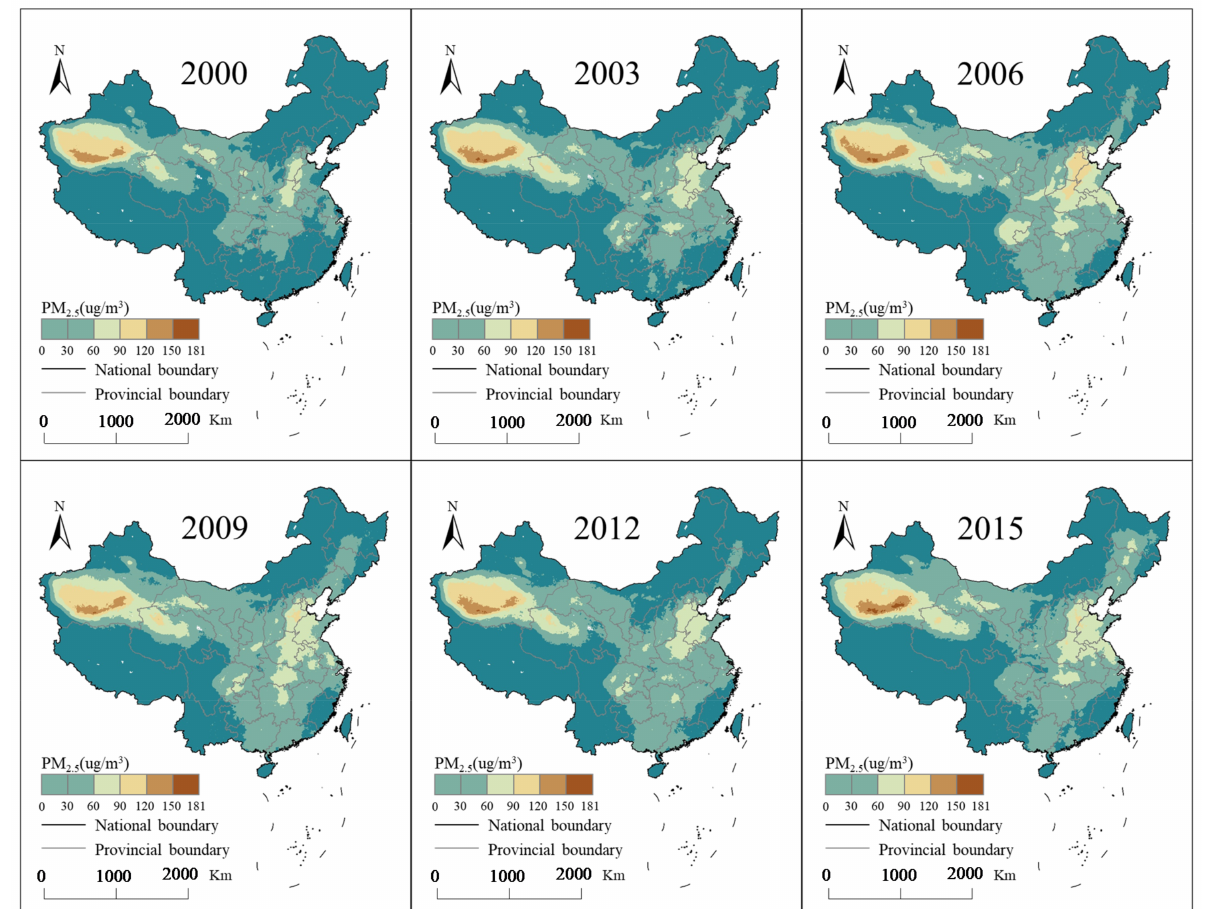
Figure 5. Spatial distribution of the fine particulate matter (PM 2.5 ) concentration from 2000 to 2015.